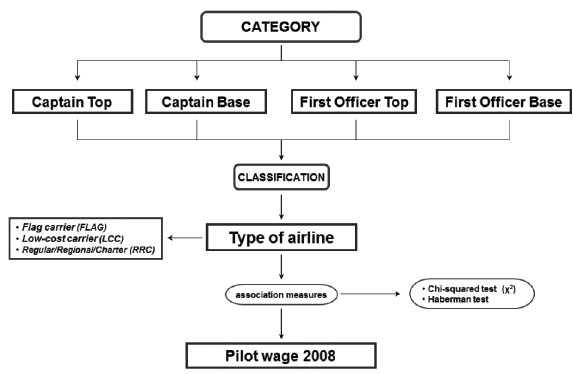
Fig. Degree of association between